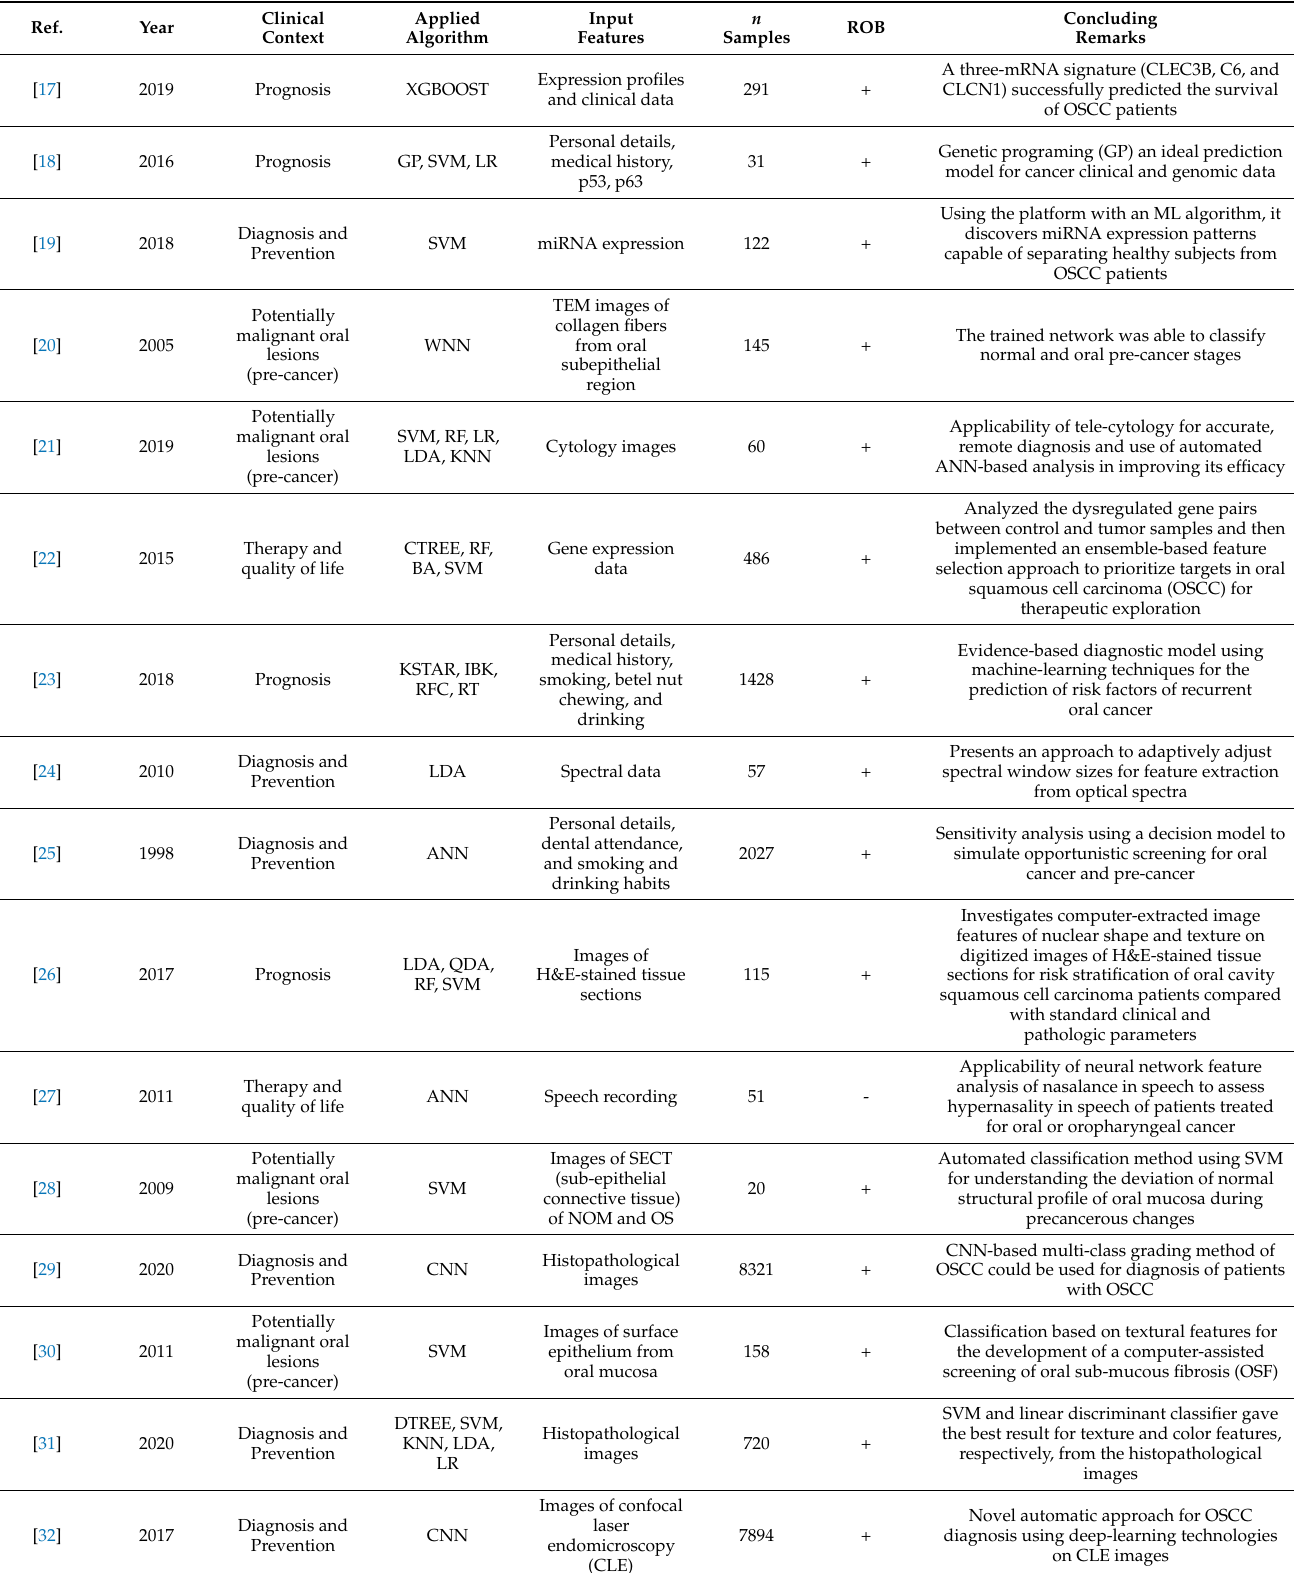
Table 1. Original research studies that applied machine-learning methods to oral cancer pathology.